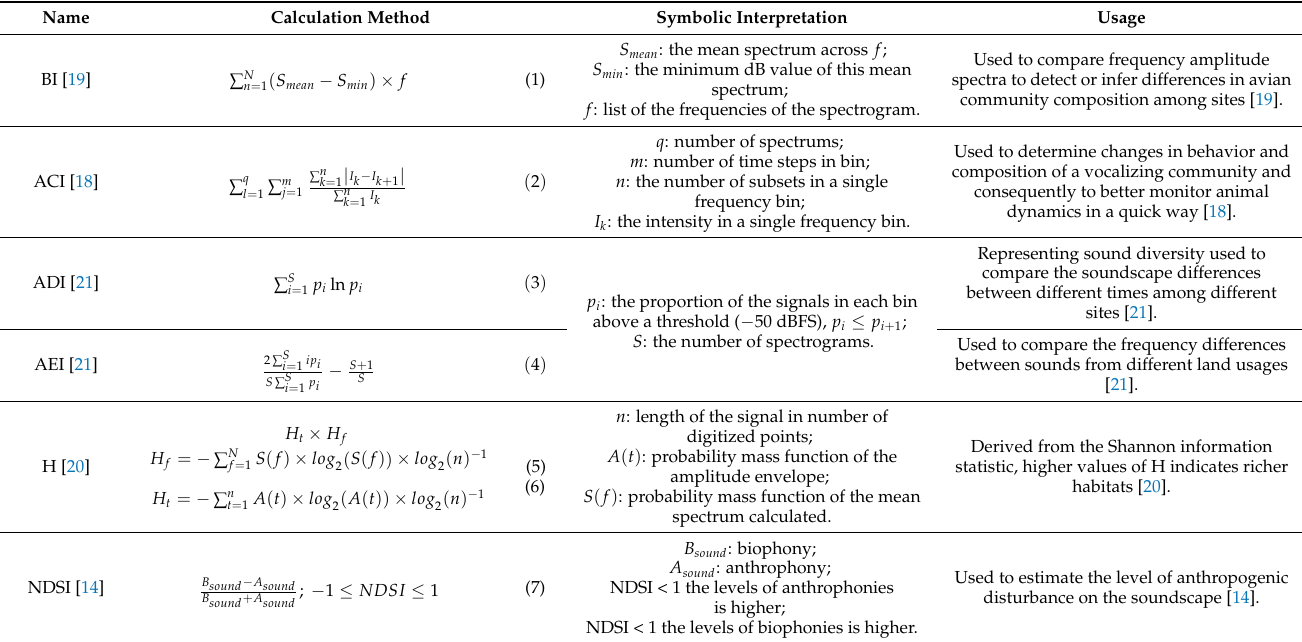
Table 2. Acoustic indices calculation